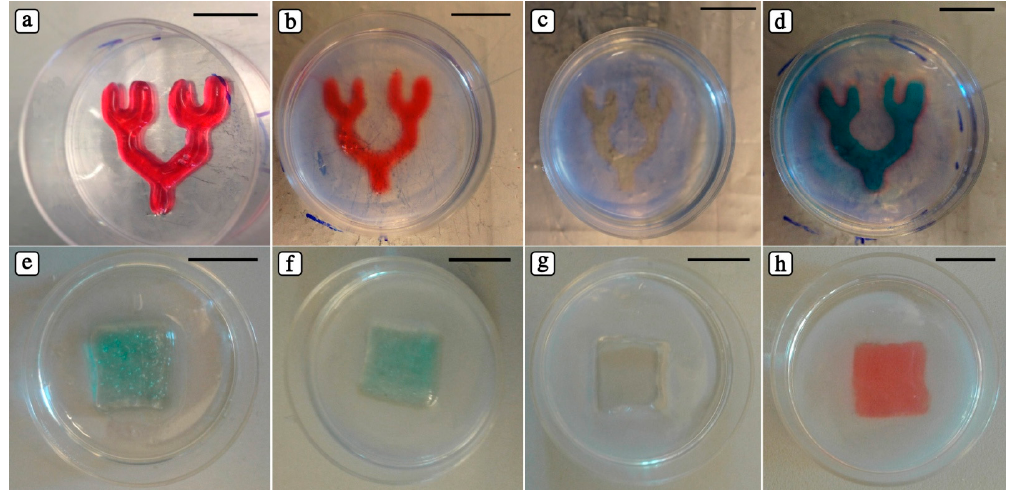
Figure 5. Optical images of 3D embedded constructs that are printed ( a , e ), covered with GelMA and photocrosslinked ( b , f ), evacuated ( c , g ), and perfused with a water-soluble food coloring ( d , h ) (scale bars: 10 mm).